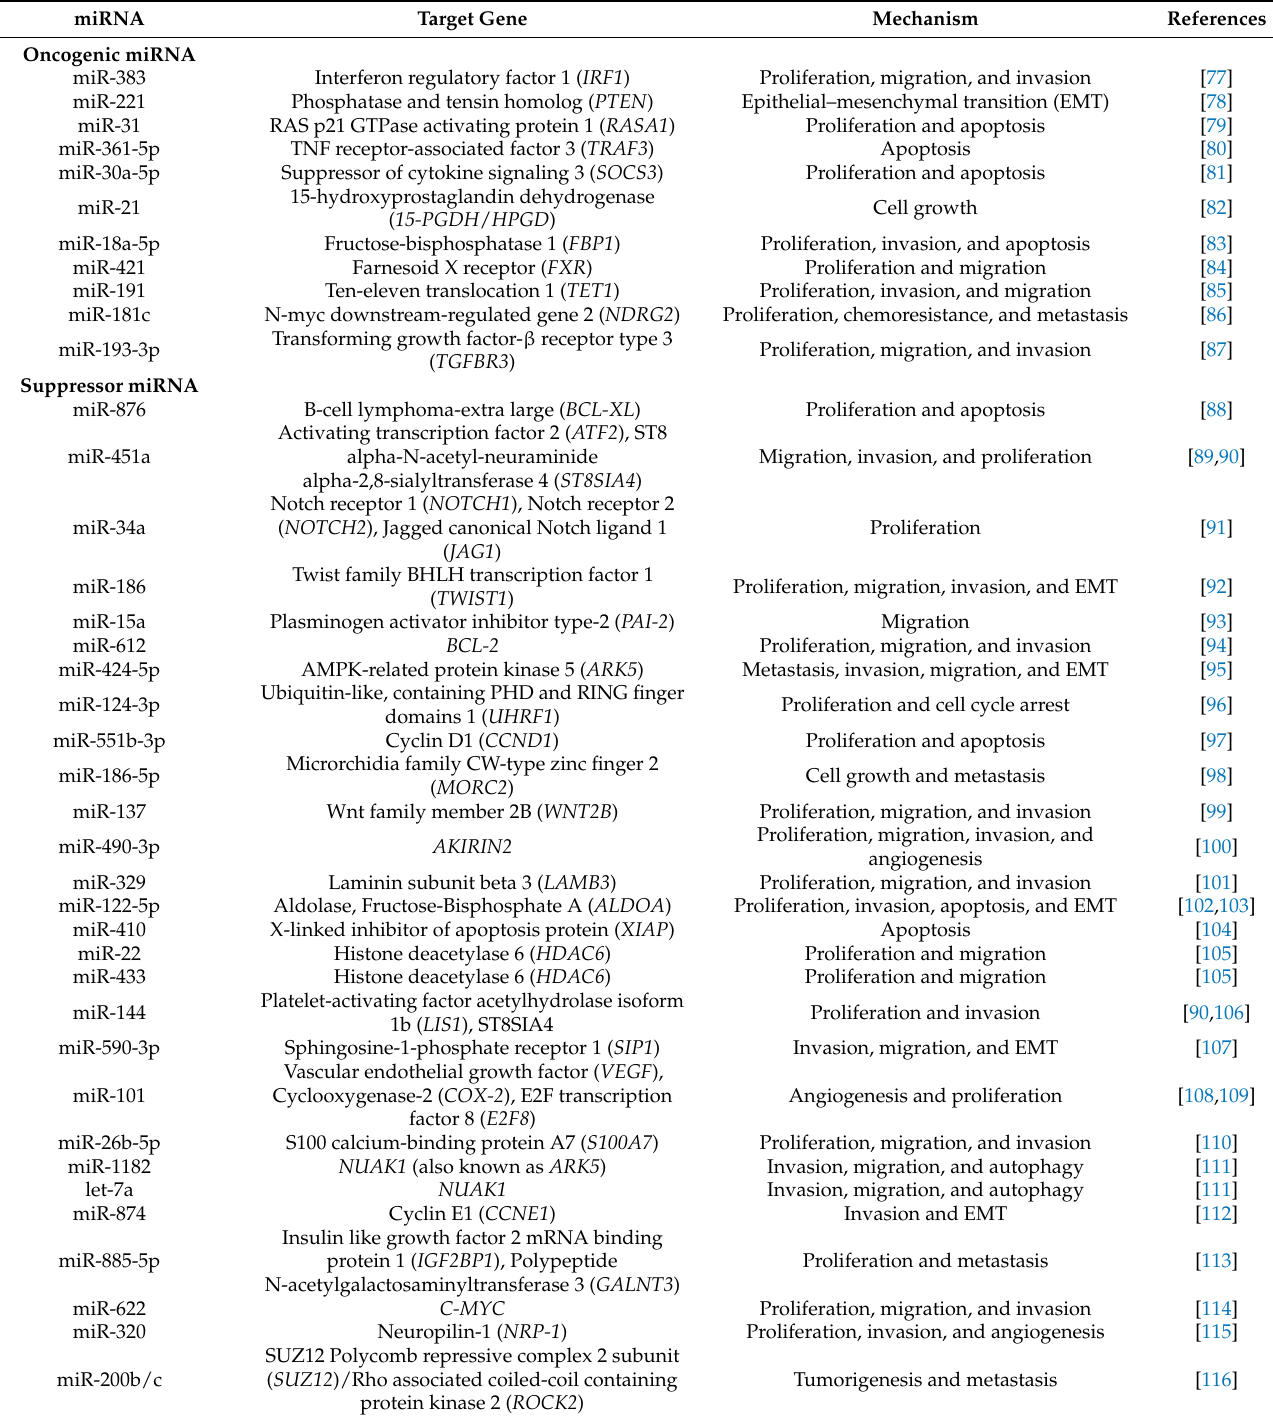
Table 2. Reported miRNAs acting as oncogenic or suppressor miRNAs in cholangiocarcinoma.